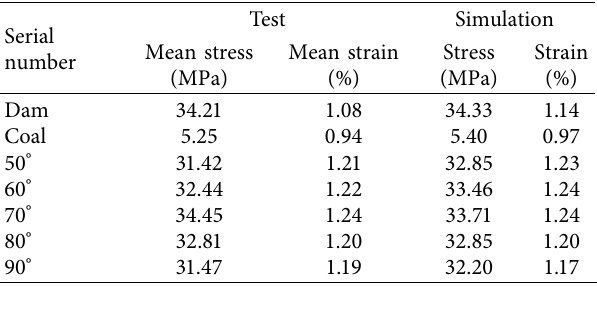
Figure 9: Test and simulated stress–strain curves. Table 3: Test and simulation